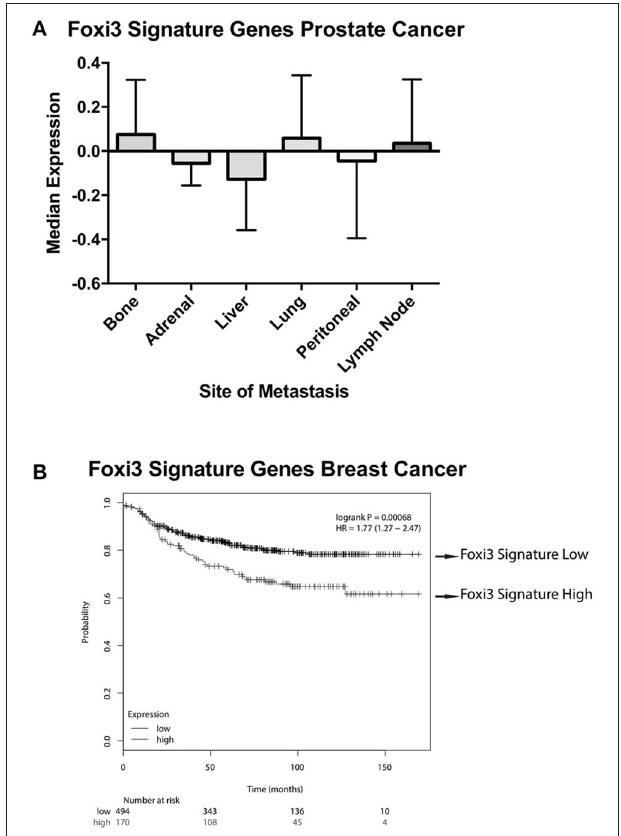
FIGURE 4 | FOXI3 signature genes in prostate and breast cancer metastasis. (A) Publicly available data ( Haider et al., 2016) (accession number: GSE74685) downloaded from the series matrix file. Data was median centered and column standardized. Next, tumors were scored for median expression of FOXI3 signature genes depicted in Figure 1 . The boxplots show median expression of these genes for tumors at distant sites of metastasis (B) Distant metastasis free survival is shown for breast cancer patient tumors scored for average expression of the FOXI3 signature genes [ p -value = 0.00068 and hazard ratio (HR) = 1.77 (1.27–2.47)]. Patient tumors were split into high and low expression groups using the autoselect threshold option on